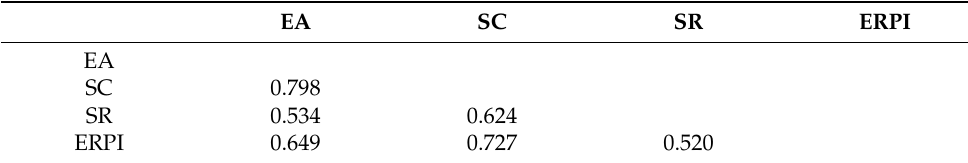
Table 6. Heterotrait–monotrait ratio for discriminant validity.